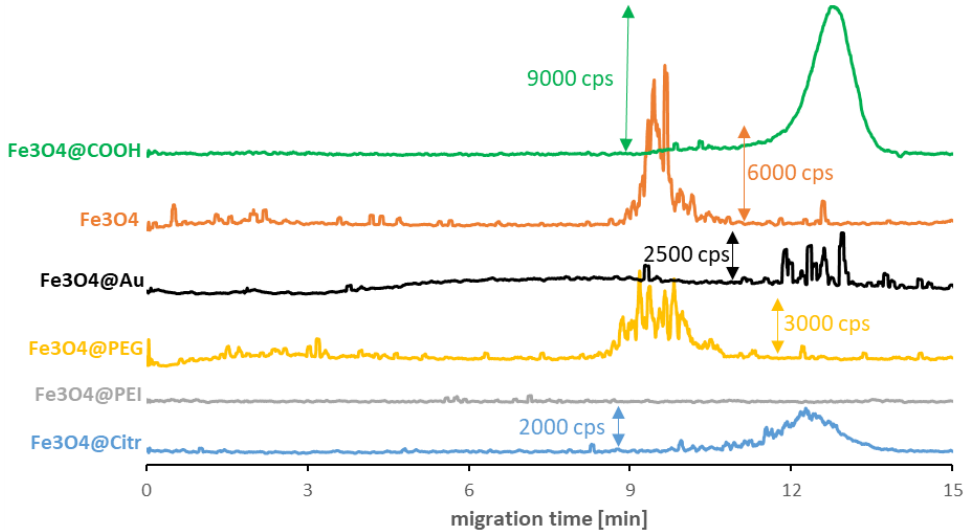
Figure 1. CE-ICP-MS/MS electropherograms of carboxyl-SPIONs (green) with 15 µ g/mL Fe and synthesized SPIONs with 10–20 µ g Fe/mL suspended in incubation buffer (10 mM phosphate buffer, pH 7.4, and 100 mM NaCl): non-modified (orange), doped with Au (black) stabilized with PEG (yellow), PEI (gray) and sodium citrate (blue); separation under optimized conditions (see Tables 1 and 2), MS/MS signal 56 Fe 16 O + . cps—counts per